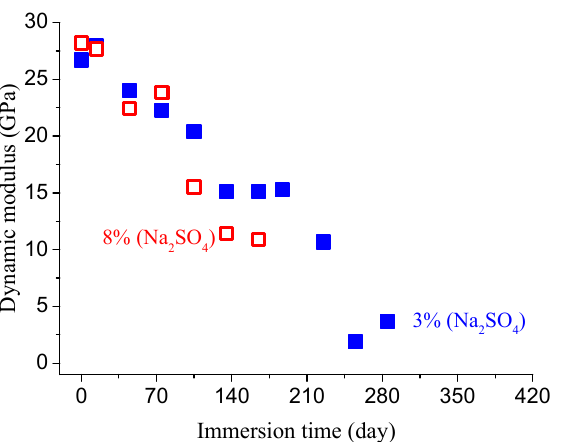
Figure 7. Dynamic modulus evolution of concrete specimens ( w / c = 0.4) after eliminating hydration in different sulfate solutions.